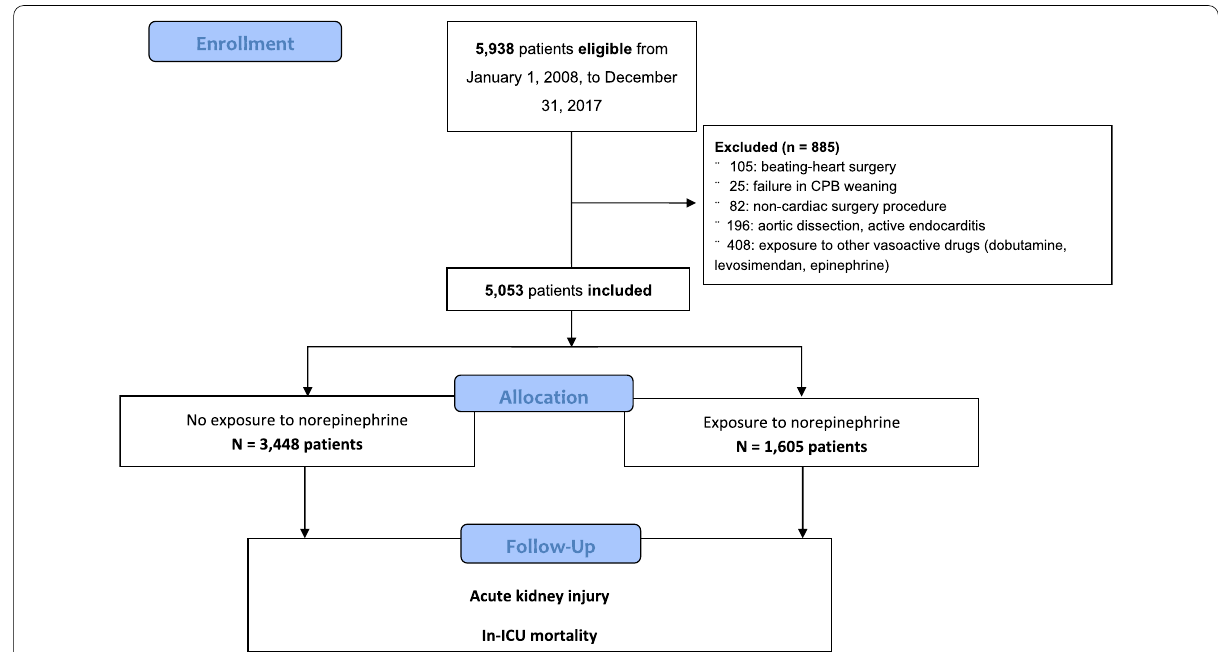
Fig. 1 Flowchart of participants. CPB: cardiopulmonary bypass, ICU: intensive care